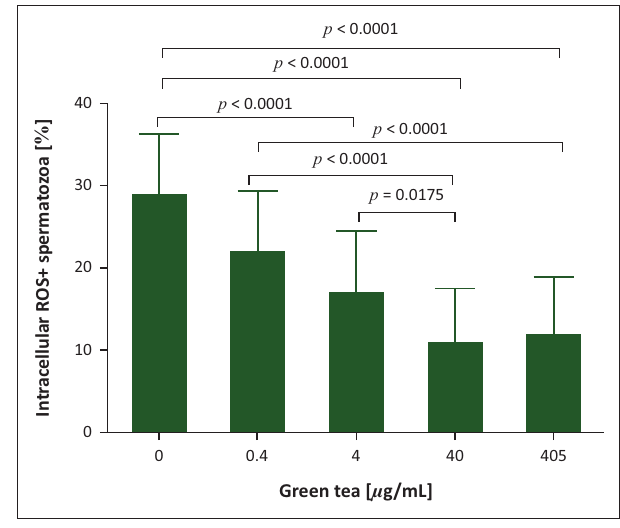
FIGURE 2: Effect of green tea aqueous extract on intact mitochondrial membrane potential. Data are represented as mean ± standard deviation from normozoospermic semen samples ( n =